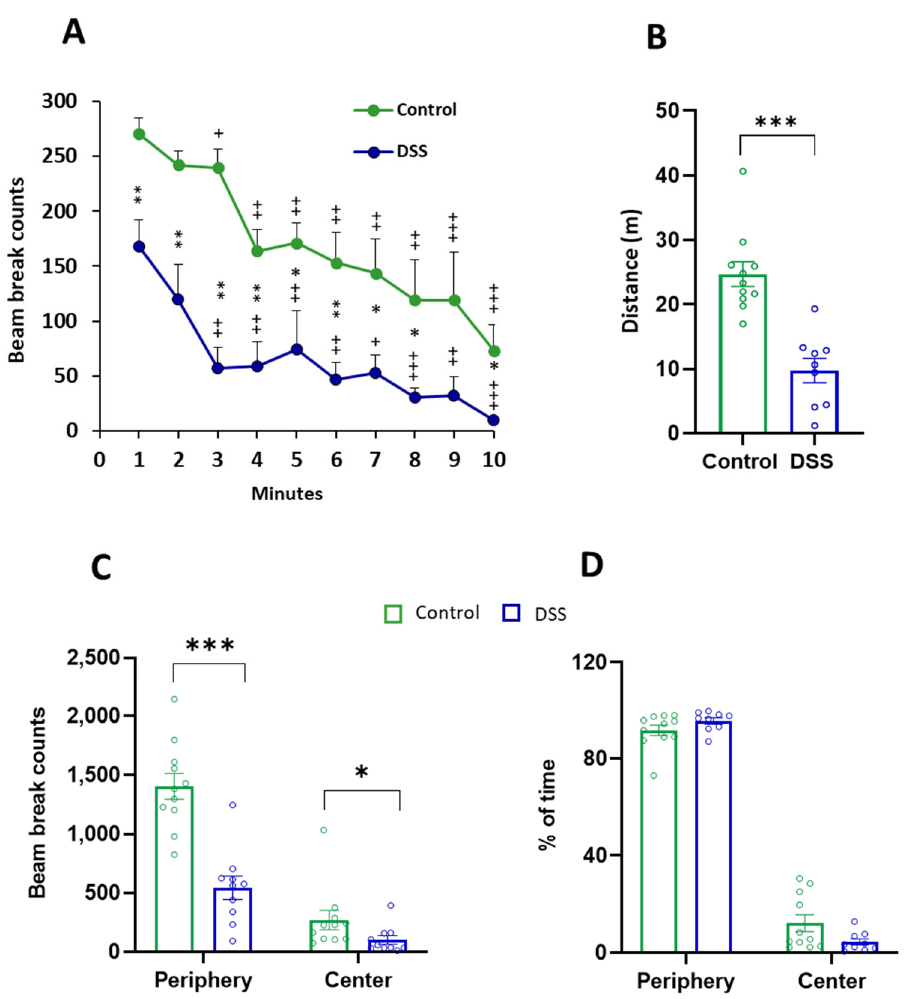
Figure 7. Horizontal motor activity in control and DSS-treated rats. Activity was measured in a 10 min period. ( A ) Horizontal activity per minute measured by the number of infrared beams broken by the rat (beam break counts). Friedman test showed that both groups were affected by the time factor (Control p < 0.0001; DSS ‐ treated rats p < 0.0001). The Wilcoxon test was used for comparisons between different minutes in the same group: + p < 0.05, ++ p < 0.01, +++ p < 0.001, first minute vs. last minutes. ( B ) Total horizontal activity as distance travelled (m). ( C ) Locomotion in the center and in the periphery of the arena as beam break counts. ( D ) Percentage of time spent within the center and within the periphery of the arena. Data are means ± SEM ( n = 10 animals per group). Student’s t ‐ test or Mann–Whitney U test for comparisons between independent groups: * p < 0.05, ** p < 0.01, *** p < 0.001, DSS ‐ treated rats vs. controls.